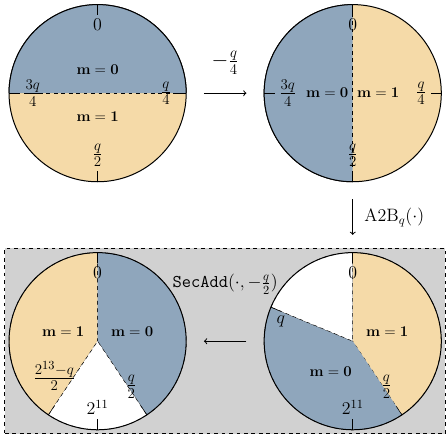
Figure 3: MaskedDecode q . The final result is a Boolean masking where the most significant bit is a masking ( m 0 ⊕ m 1 ) = m . Adapted from [OSPG18] to use A2B q instead of TransformPower2 . Operations that require Boolean masking grouped in light